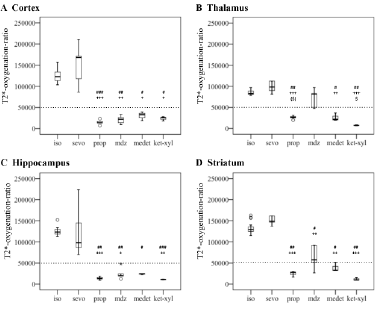
Figure 5. Differences of T2*-oxygenation-ratio between anes- thetic agents. A, cortex; B, thalamus; C, hippocampus; D, striatum. Diagrams are box plots made with IBM SPSS software. Each box plot represents median, 25 th and 75 th percentile, minimum and maximum values, outliers ( u ) and extremes (*). Y-axis: regional T2*-oxygenation- ratio. Compared to isoflurane: # p , 0.05, ## p , 0.01, ### p , 0.001. Compared to sevoflurane: + p , 0.05, ++ p , 0.01, +++ p , 0.001. Compared to midazolam: $ p , 0.05, ( $ ) p=0.053. iso, isoflurane; sevo, sevoflurane; prop, propofol; mdz, midazolam; medet, medetomidine; ket-xyl, ketamine-xylazine. The dotted line at 50000 shows a separation between high and low T2*-oxygenation-ratio.